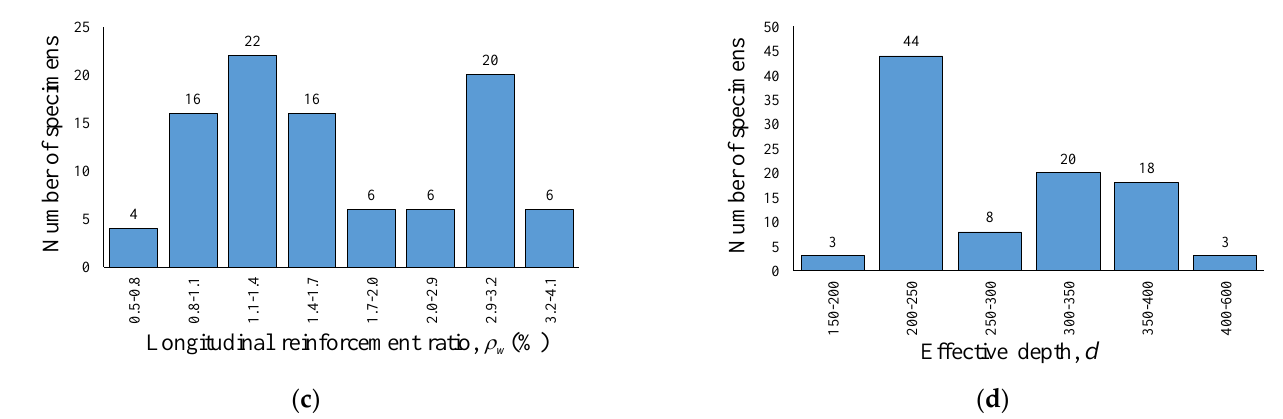
Figure 4. Distribution of key parameters in RCA with shear reinforcement. ( a ) Compressive strength of concrete, MPa. ( b ) Shear span-to-depth ratio. ( c ) Longitudinal reinforcement ratio. ( d ) Effective depth.